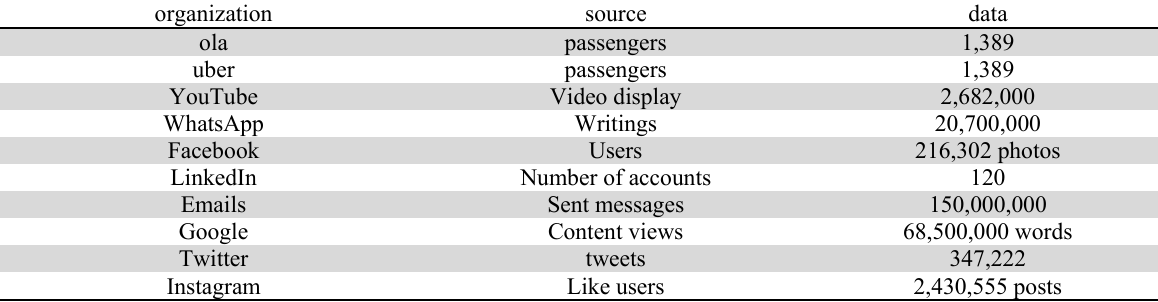
Table 1 Data generated in unit time period in 2017